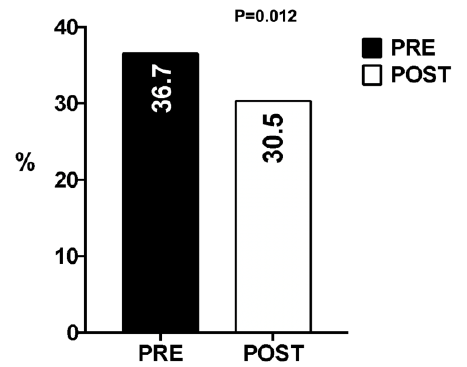
Figure 2. Acute kidney injury 30-day mortality rates.